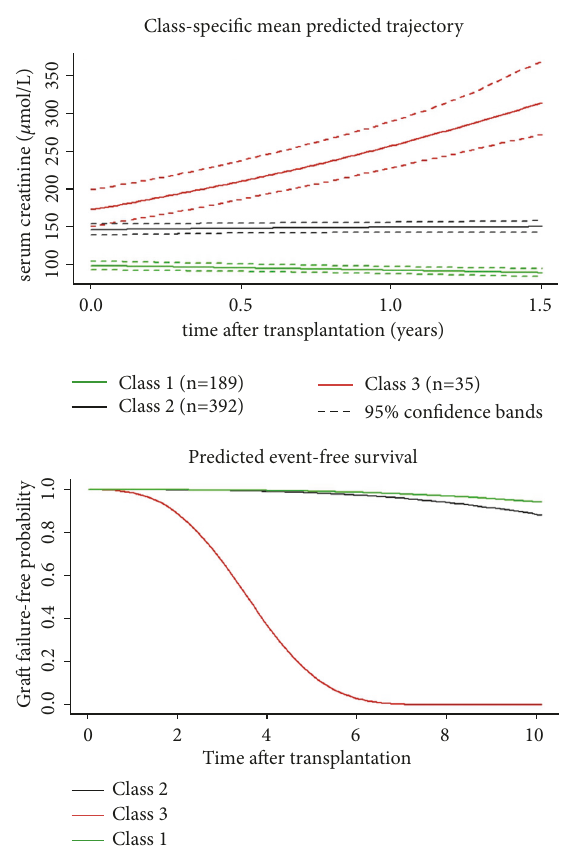
Figure 2: Class-specific predicted mean trajectories (top panel) and class-specificpredicted event-freeprobabilities (bottom panel)from the final joint latent-class mixed model; class 1 (n=189) is in green, class 2 (n=392) in black, and class 3 (n=35) in red. Dashed lines are the computed 95% confidence